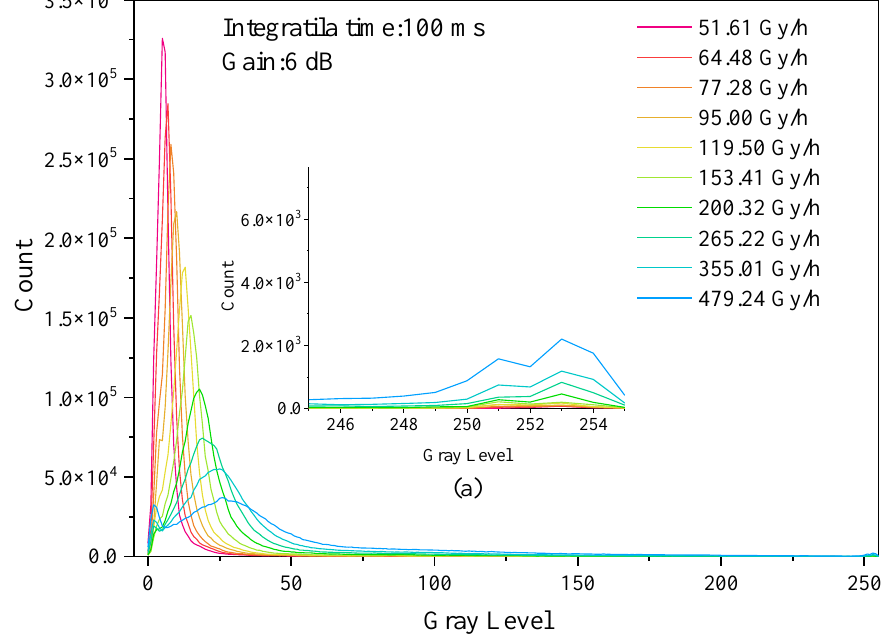
Figure 1. Statistical histogram of dose rate variation. ( a ) belongs to local enlarged figure. Table 4. Error analysis of fitting results of characteristic values under different conditions in dark irradiation